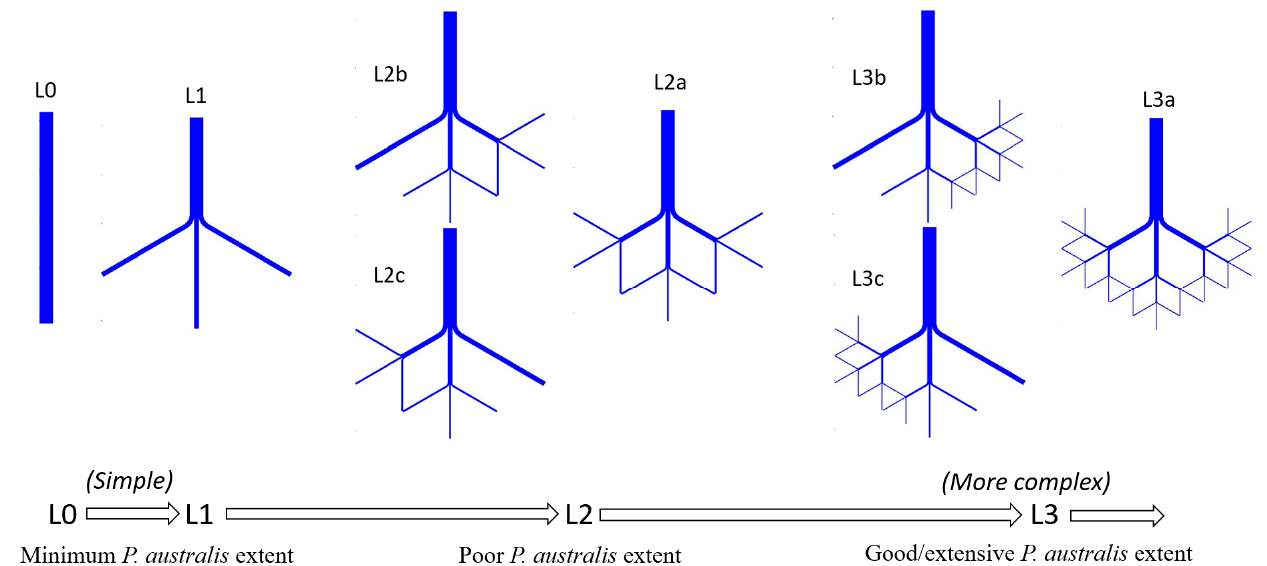
Figure 5. Multiple levels of multichannel deltaic systems. Table 1. Summary of the complexity index and topologic characteristics of each idealized deltaic